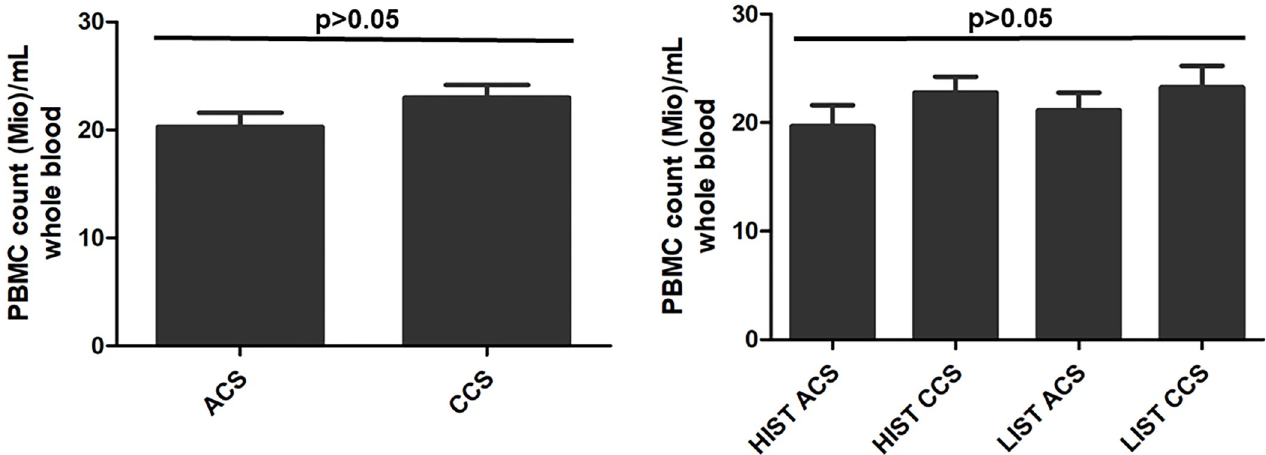
Fig 1. Similar whole blood PBMC counts. PBMC counts were similar in all ACS versus CCS patients (left); also, PBMC counts were similar in ACS versus CCS patients stratified by permanent statin treatment intensity (HIST: high- to moderate-intensity statin treatment; LIST: low-intensity statin treatment) (right).